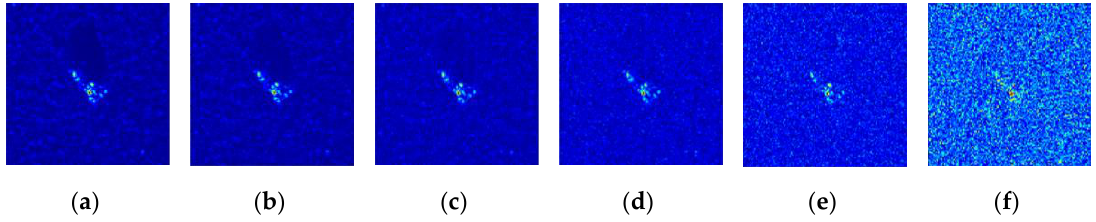
Figure 13. The noise interrupted images with different signal-to-noise ratios (SNRs). ( a ) The original image, ( b ) the SNR at 10 dB, ( c ) the SNR at 5 dB, ( d ) the SNR at 0 dB, ( e ) the SNR at −5 dB, and ( f ) the SNR at −10 dB.